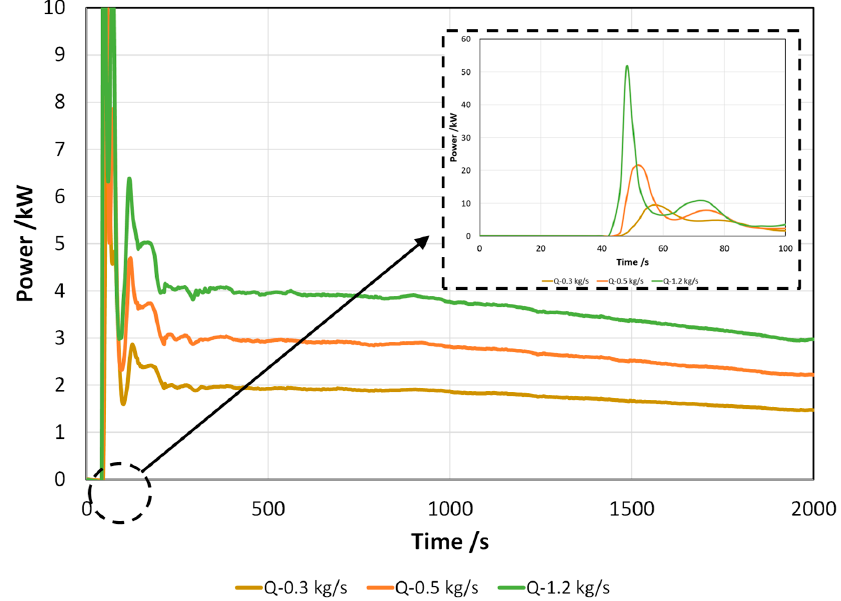
Figure 8. Discharge power for different HTF flow rates for four layers and an HTF inlet at 12 °C.